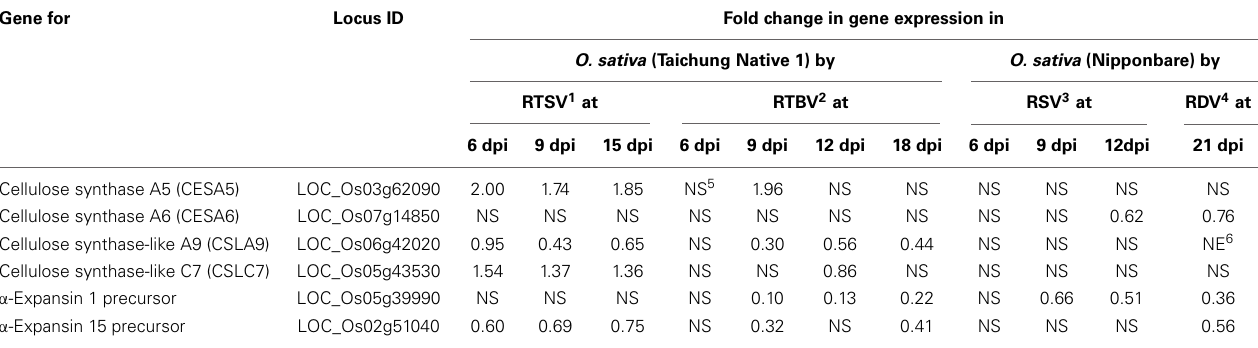
Table 3 | Changes in expression of six cell wall-related genes in rice plants infected with Rice dwarf virus (RDV), Rice stripe virus (RSV), Rice